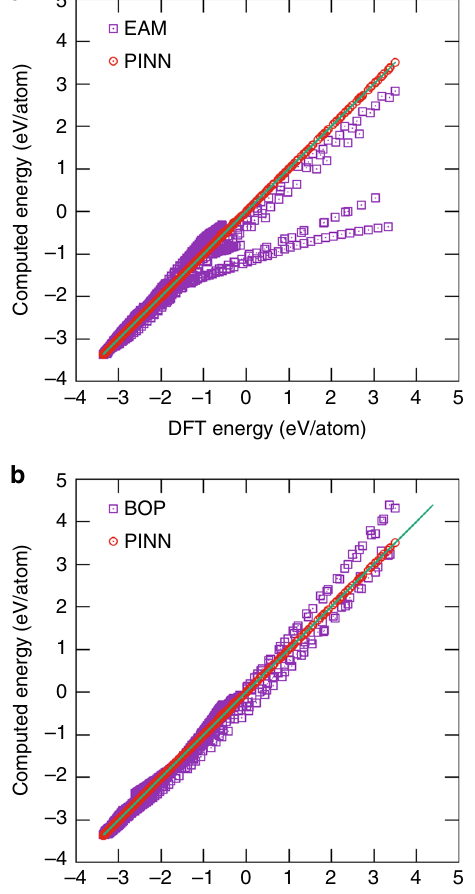
Fig. 8 Comparison of DFT versus potentials. Energies of atomic con fi gurations in the DFT database used for training and validation are compared with predictions of the a EAM Al potential 54 and b BOP potential. The BOP parameters were fi tted to the DFT database and permanently fi xed. The PINN potential predictions are included for comparison. The straight line represents the perfect fi